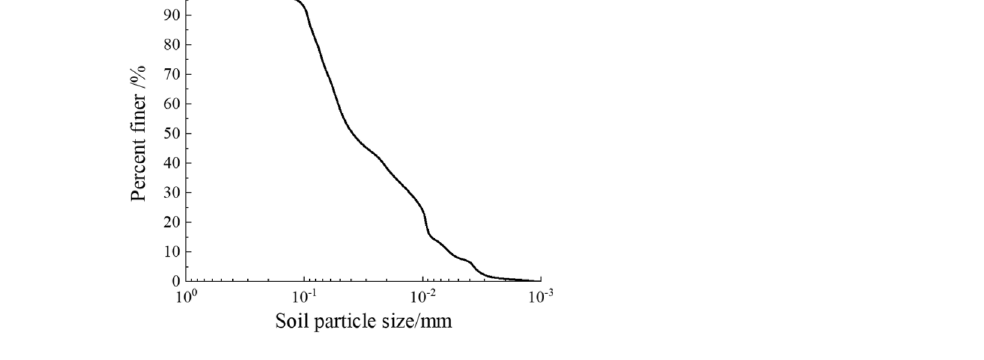
Figure 1. Particle grading curve.